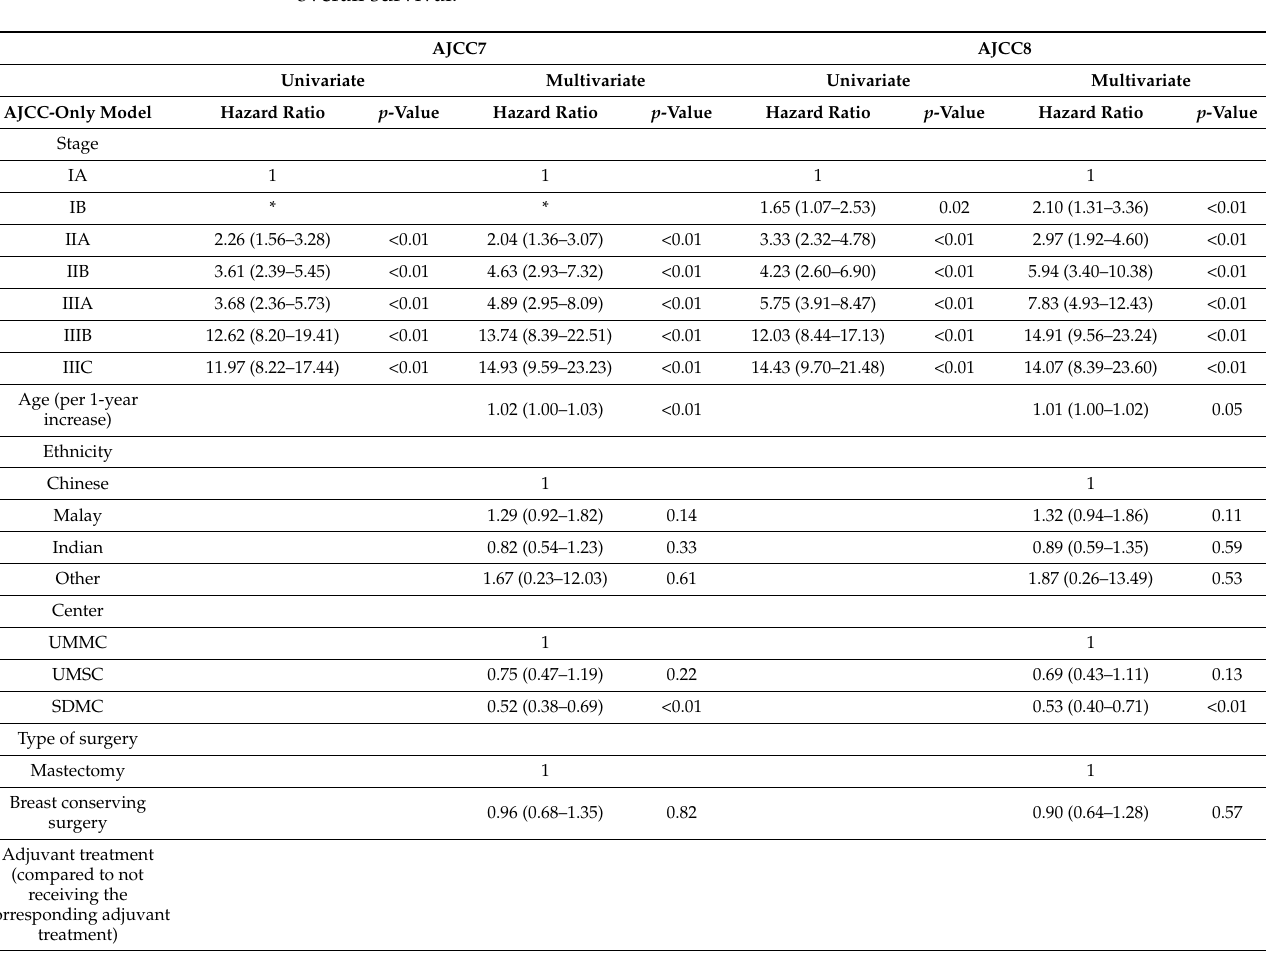
Table 4. Association between stage and overall survival among patients with breast cancer by staging system (AJCC7 and AJCC8), and concordance for AJCC7 and AJCC8 staging to predict overall survival. AJCC7 AJCC8 Univariate Multivariate